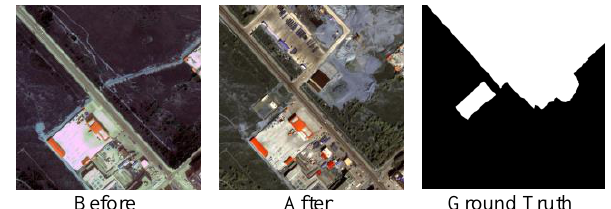
Figure 7. High resolution remote sensing images and the ground truth of land cover changes.